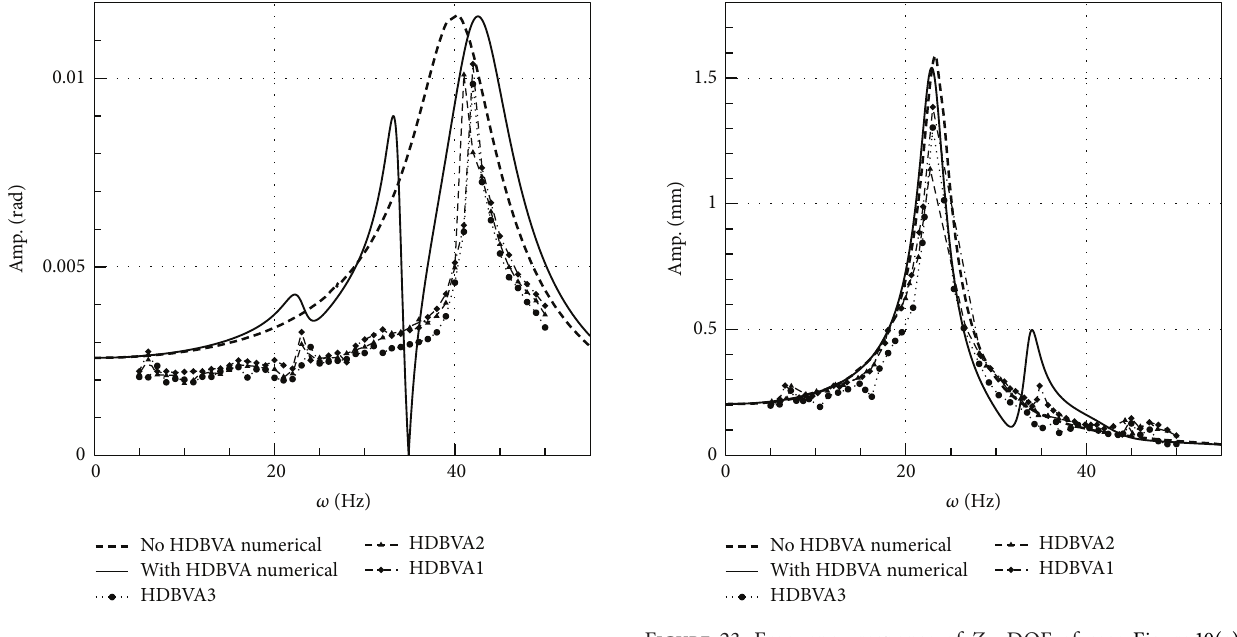
Figure 21: Frequency response of 𝜃 𝑌 DOF of case Figure 10(a), HDBVAs start at the near-force point.